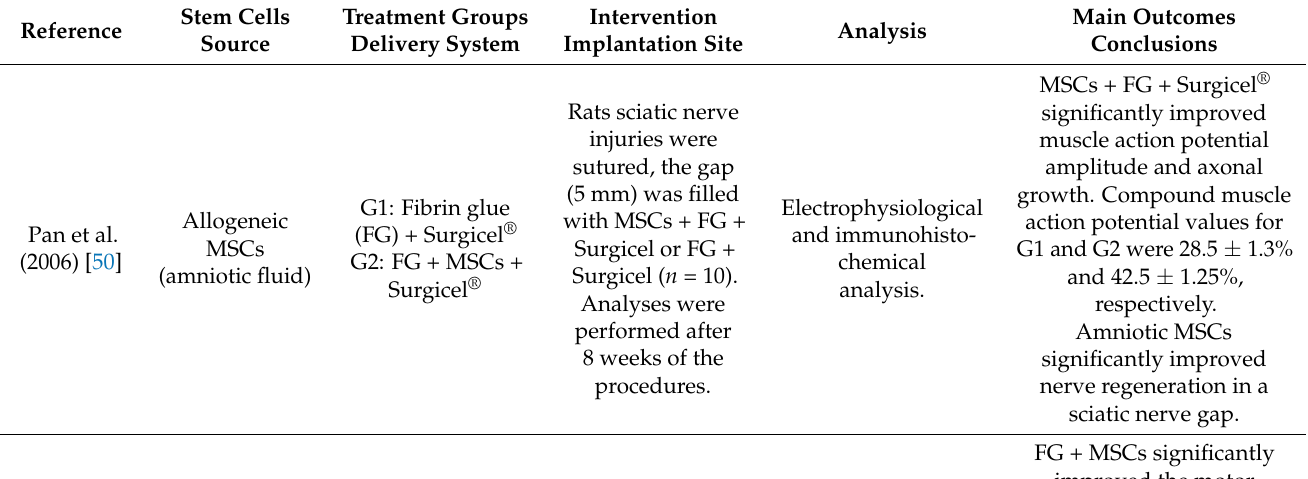
Table 1. Studies selected according to eligibility criteria, in peripheral nerve injuries, in chronologi- cal